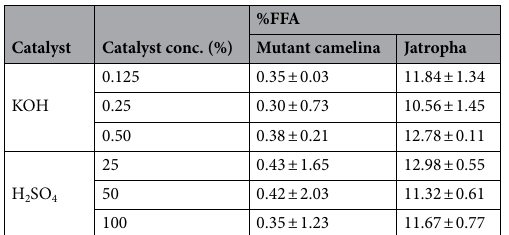
Catalyst Catalyst conc. (%)